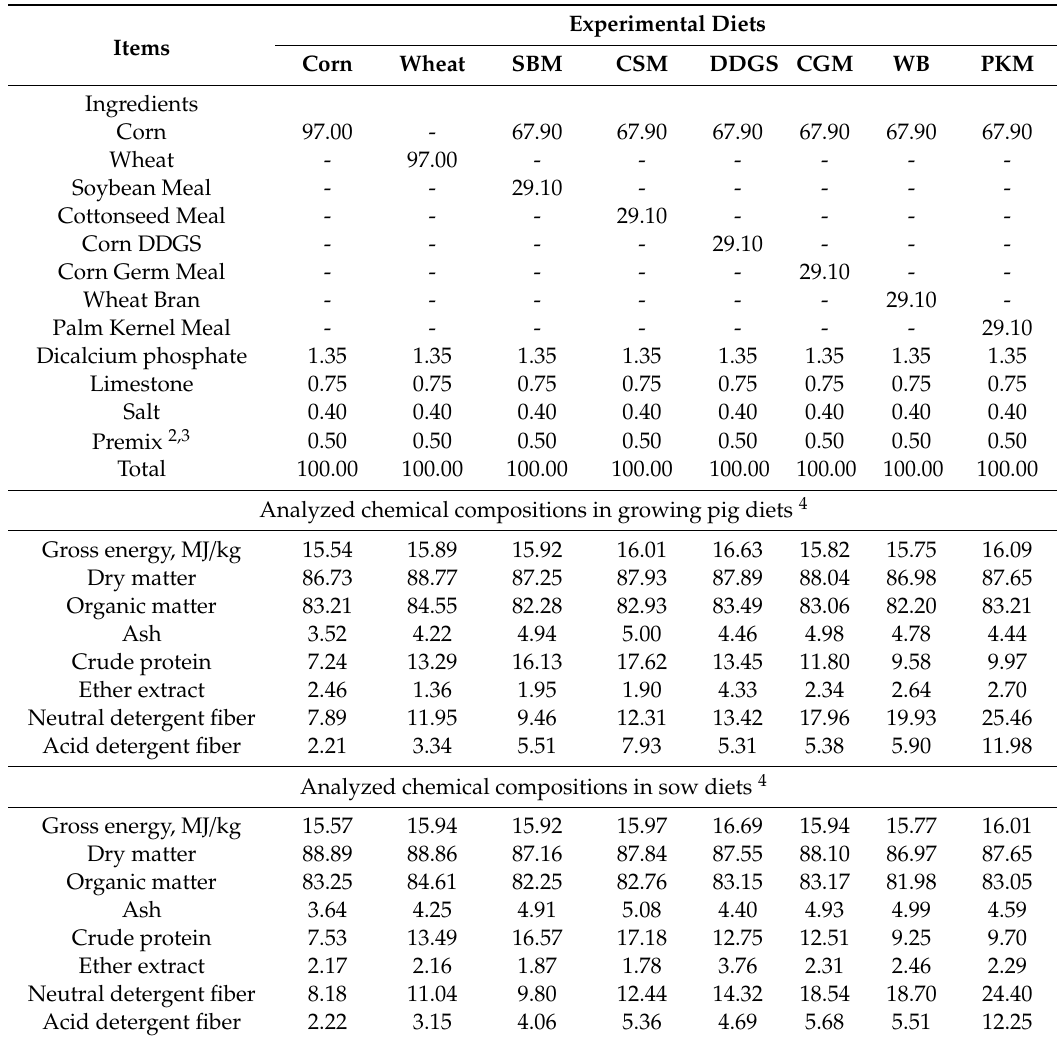
Table 2. Ingredient components and analyzed chemical compositions of the experimental diets 1 (%, as-fed